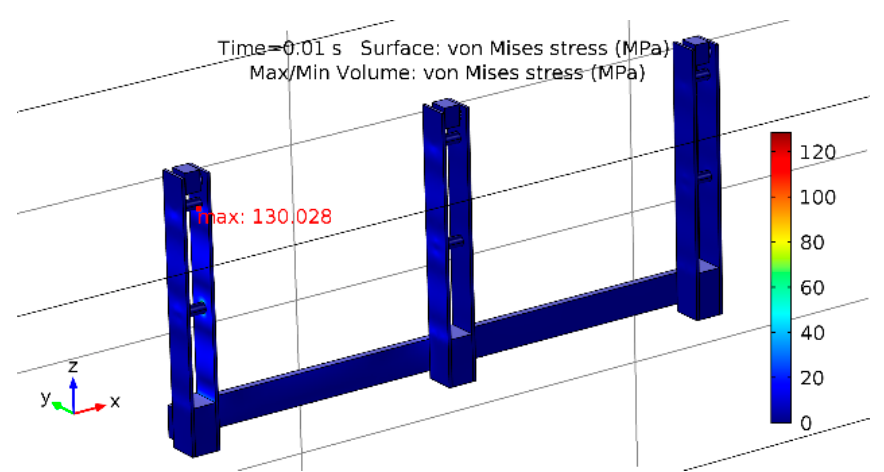
Figure 14. Von Mises stress distribution over the earthing switch.